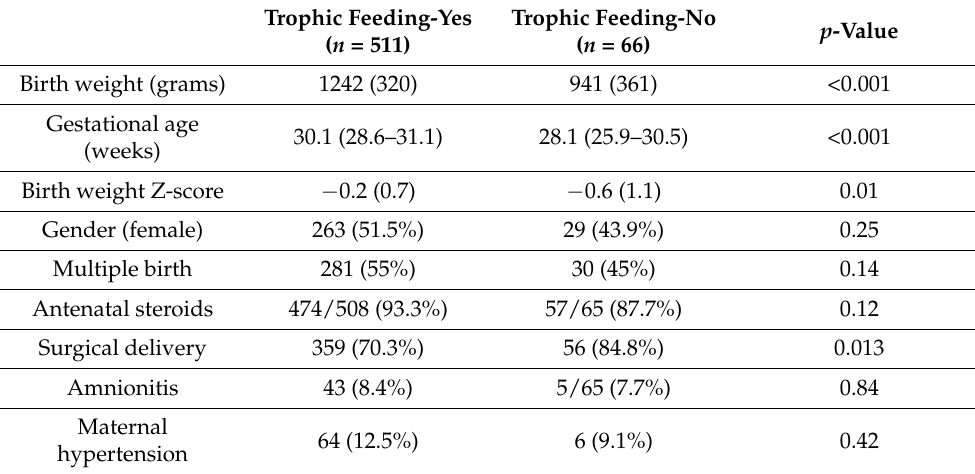
Table 1. Comparison of infants exposed to trophic feeding and those not exposed to trophic feeding. (Israel,